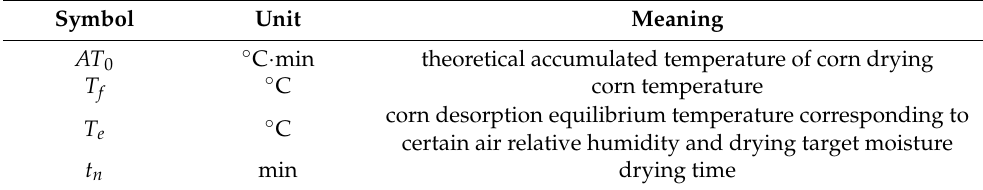
Table 4. Formula (4) symbols and